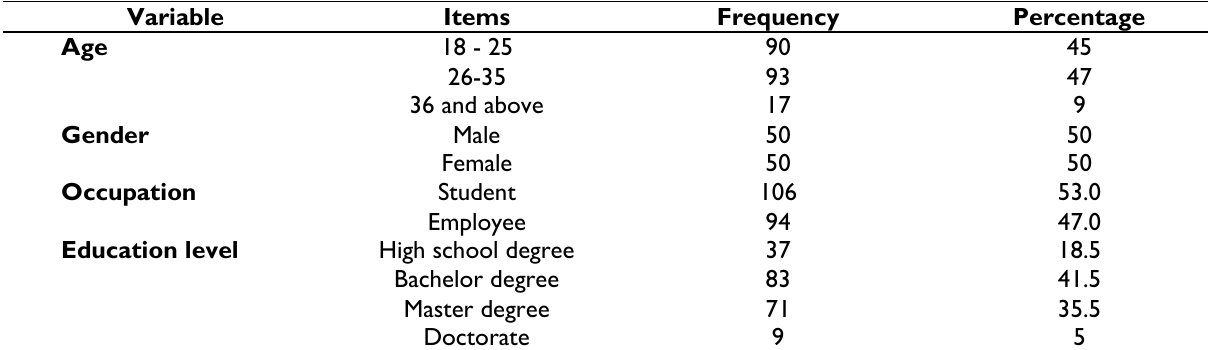
Table 1. Demographic information